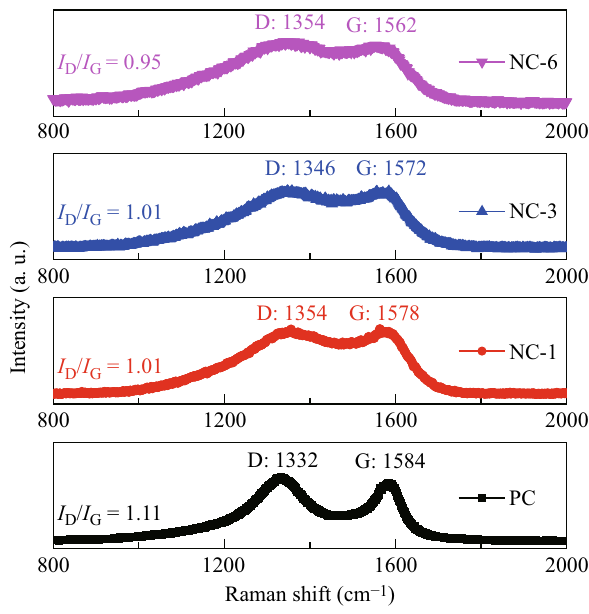
Fig. 4 Raman spectra of the PC and NCs